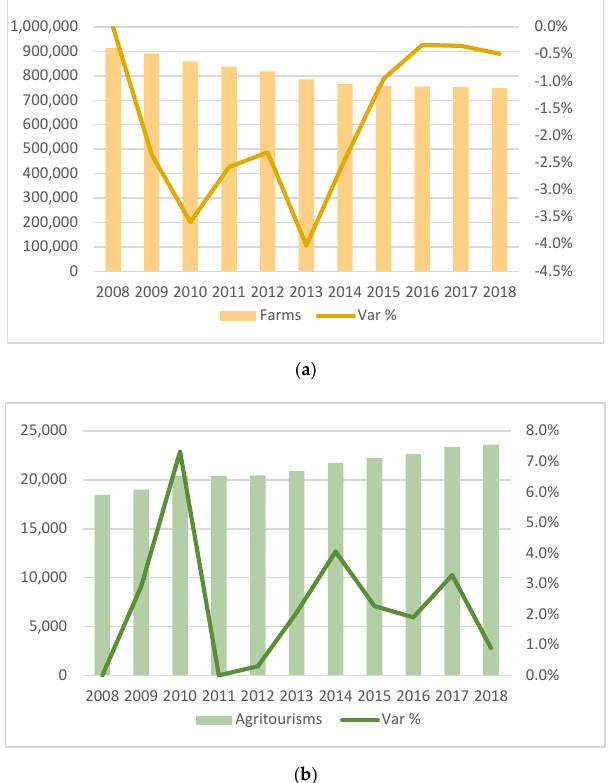
Figure 1. Trends in agricultural enterprises from 2008 to 2018 in Italy: ( a ) farms; ( b ) agritourisms. Elaboration based on InfoCamere 2019 [73] and ISTAT 2019 [2].